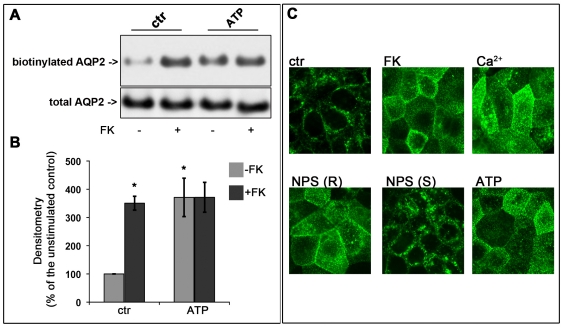
Effect of ATP stimulation on AQP2 trafficking in MCD4 cells.(A) MCD4 cells were preincubated with 100 µM ATP or used under control conditions and then stimulated with FK 10−4 M. The amount of apical AQP2 was quantitated by apical surface biotinylation. ATP caused AQP2 membrane accumulation comparable to that found in FK treated cells. The total amount of AQP2 in the starting preparation was comparable in each experimental condition (total AQP2). (B) Densitometric analysis of the 29 kDa biotinylated AQP2 band. Results are expressed as mean values ± S.E.M. The values obtained in three independent experiments are expressed as percentages of the basal condition. Data were compared by one-way Anova and Tukey's multiple comparison test (* P<0.05 relative to ctr.) (C) Immunolocalization of AQP2 and analysis by confocal microscopy. MCD4 cells were grown on permeable support to full confluence fixed and immunostained with antibodies against AQP2. In resting cells, AQP2 was mainly detectable in sub-apical vesicles (ctr). After FK treatment, AQP2 localized to the apical membrane (FK). A similar apical localization was observed in cells exposed to 5 mM calcium (Ca2+) or to NPS-R 568 (NPS R) or to ATP (ATP) treatments. By contrast, no AQP2 redistribution was observed after exposure to the inactive NPS enantiomer NPS-S (NPS-S).